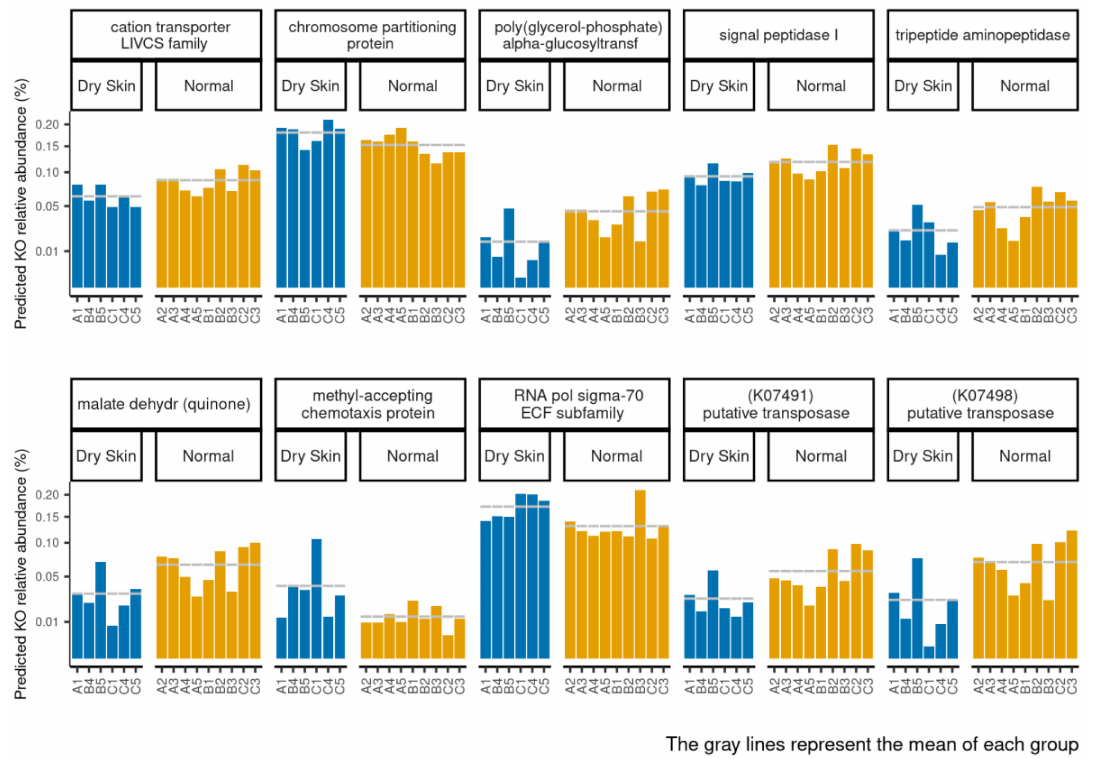
Figure 12. Abundance of each significantly different function in normal and dry skin groups within each sample inferred by PICRUSt2. The grey lines represent the mean of each